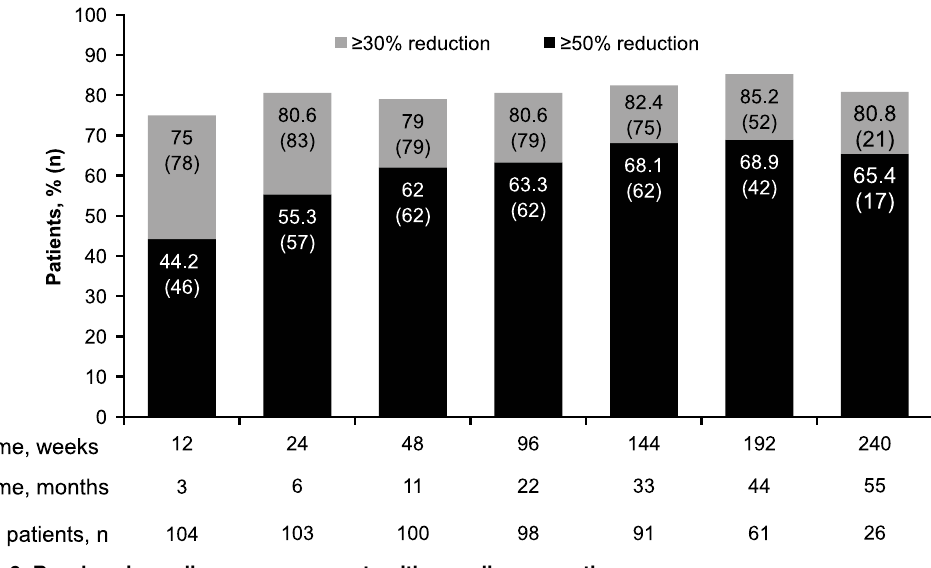
Fig 3. Renal angiomyolipoma response rate with everolimus over time.